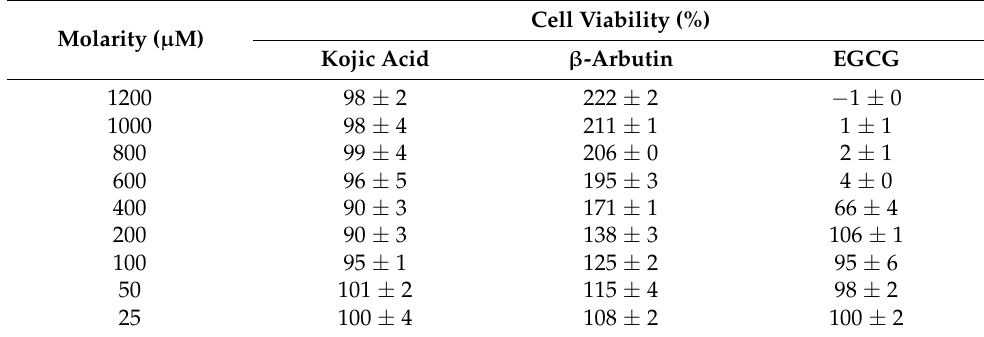
Table 1. Cell viability under each compound